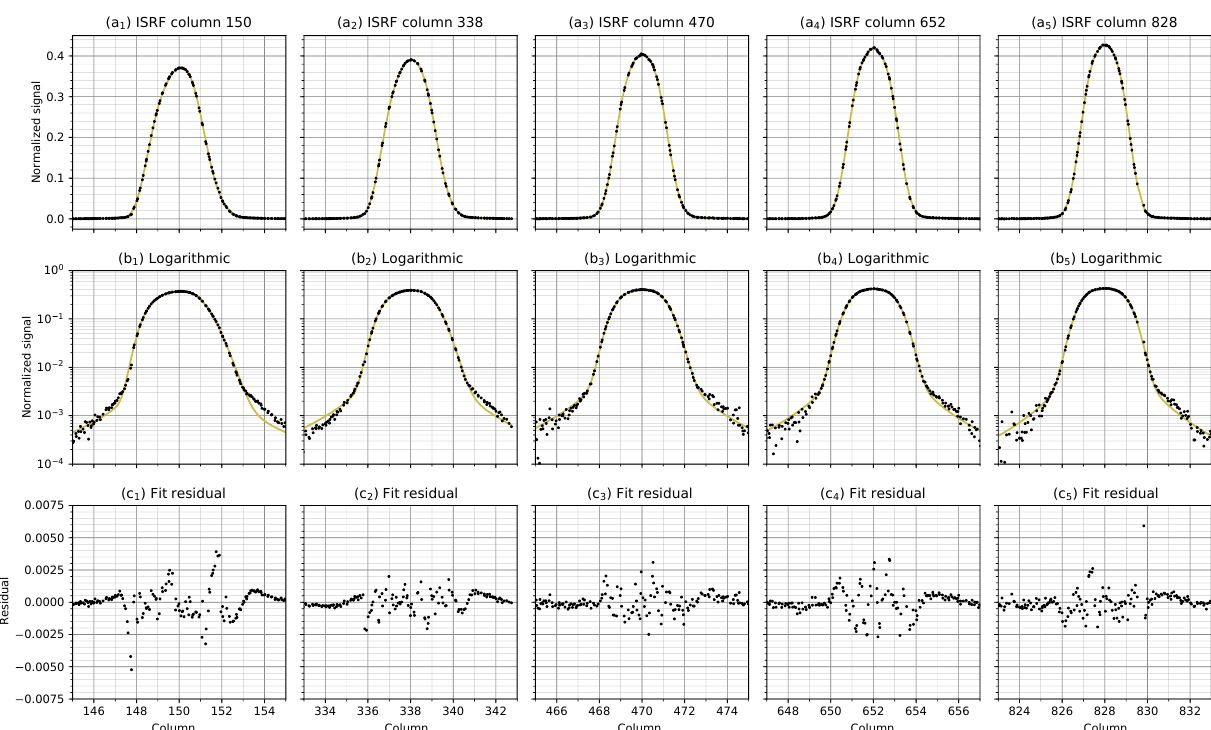
Figure 4. Five typical SWIR ISRFs determined from on-ground measurements with an external laser through the TROPOMI radiance port. The upper panels (a) show the shapes of the ISRF at location: columns 150, 338, 471, 652 and 828 and rows 24, 76, 118, 155 and 191. The middle panels (b) show the same data on a logarithmic scale. The lower panels (c) show the difference between the ISRF data points and the ISRF fit (end of stage